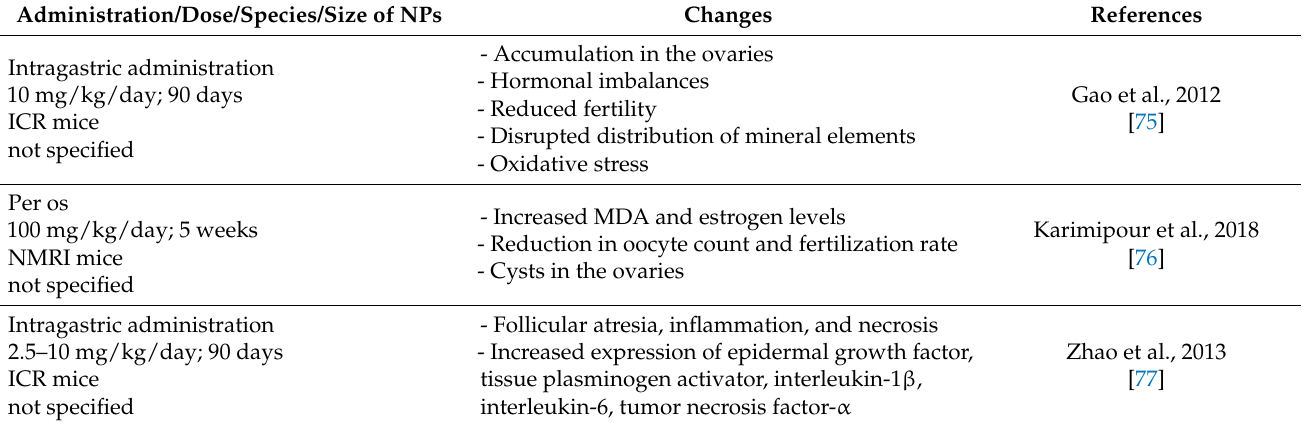
Table 6. Alterations in the female reproductive system caused by TiO 2